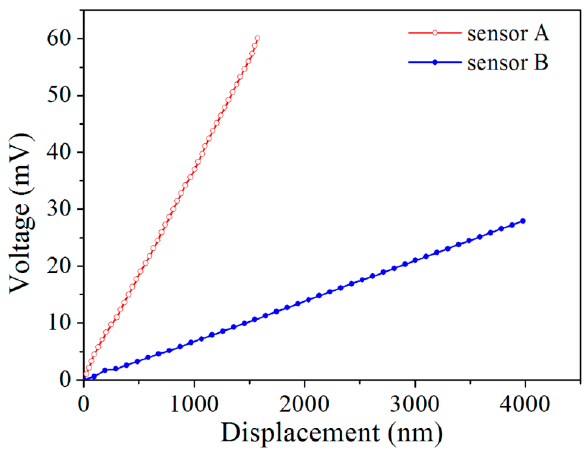
Figure 12. Output voltage as a function of the displacement. Table 3. Sensitivity of the two sensors under irradiation of e-beams.